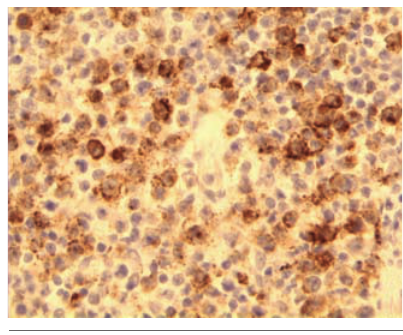
PTLD.Figure 2. Atypical lymphoid cells labeled with